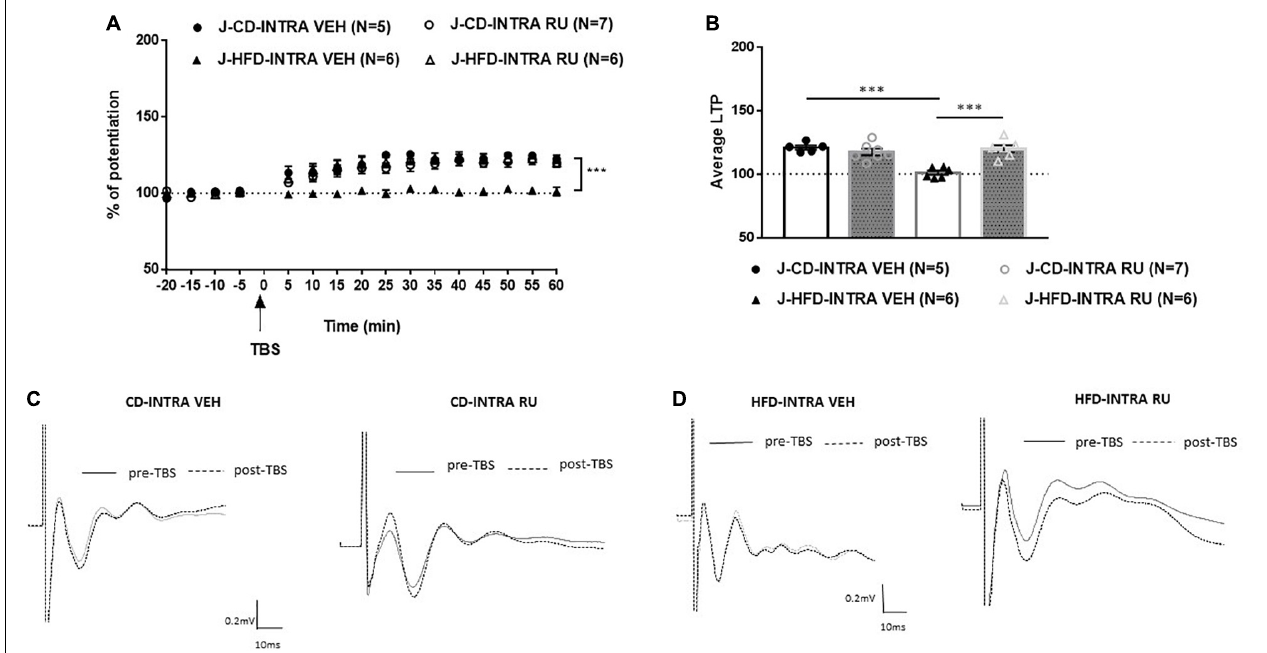
FIGURE 7 | Effects of local intra-mPFC GR blockade on prefrontal LTP in HFD- and CD-fed juveniles. (A) Normalized fEPSPs recorded in vivo before and after TBS of the BLA-mPFC pathway. Each data point shows the average fEPSPs of the preceding 5 min. (B) Average LTP shown in panel A over the 60 min after TBS. (C,D) Representative average waveforms before and after TBS Horizontal bar = 10 ms; vertical bar = 0.2 mV. For juvenile animals locally, microinjected with RU-486 (RU) or vehicle 30 min prior to TBS. RU treatment rescued HFD-impaired LTP in HFD-fed animals, and had no effect on control CD-fed animals. Two-way ANOVA with repeated measures on the 12 post-TBS time points showed significant effects of Diet ( ∗∗∗ p < 0.001), Drug ( ∗∗∗ p < 0.001), and Diet × Drug interaction ( ∗∗∗ p < 0.001). Post hoc comparison showed a significant difference between vehicle and RU-486-treated HFD-fed groups ( ∗∗∗ p < 0.001), but no significant difference between the CD-fed groups. Error bars show standard error of the mean